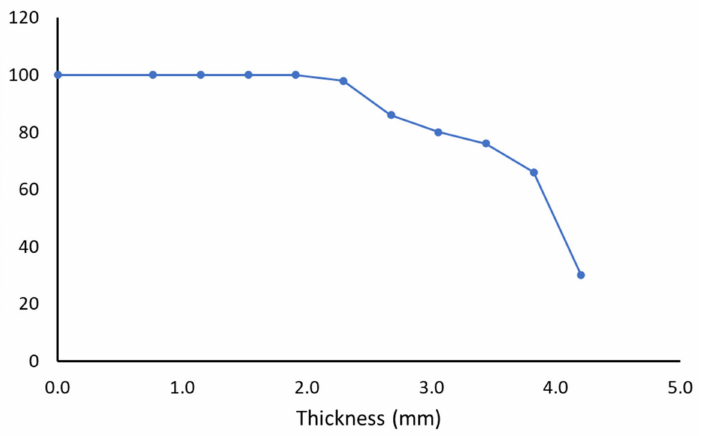
Figure 12. Performance of the constructed capacitive touch sensors in the smart textile (items 4,7,8,9,10 in Figure